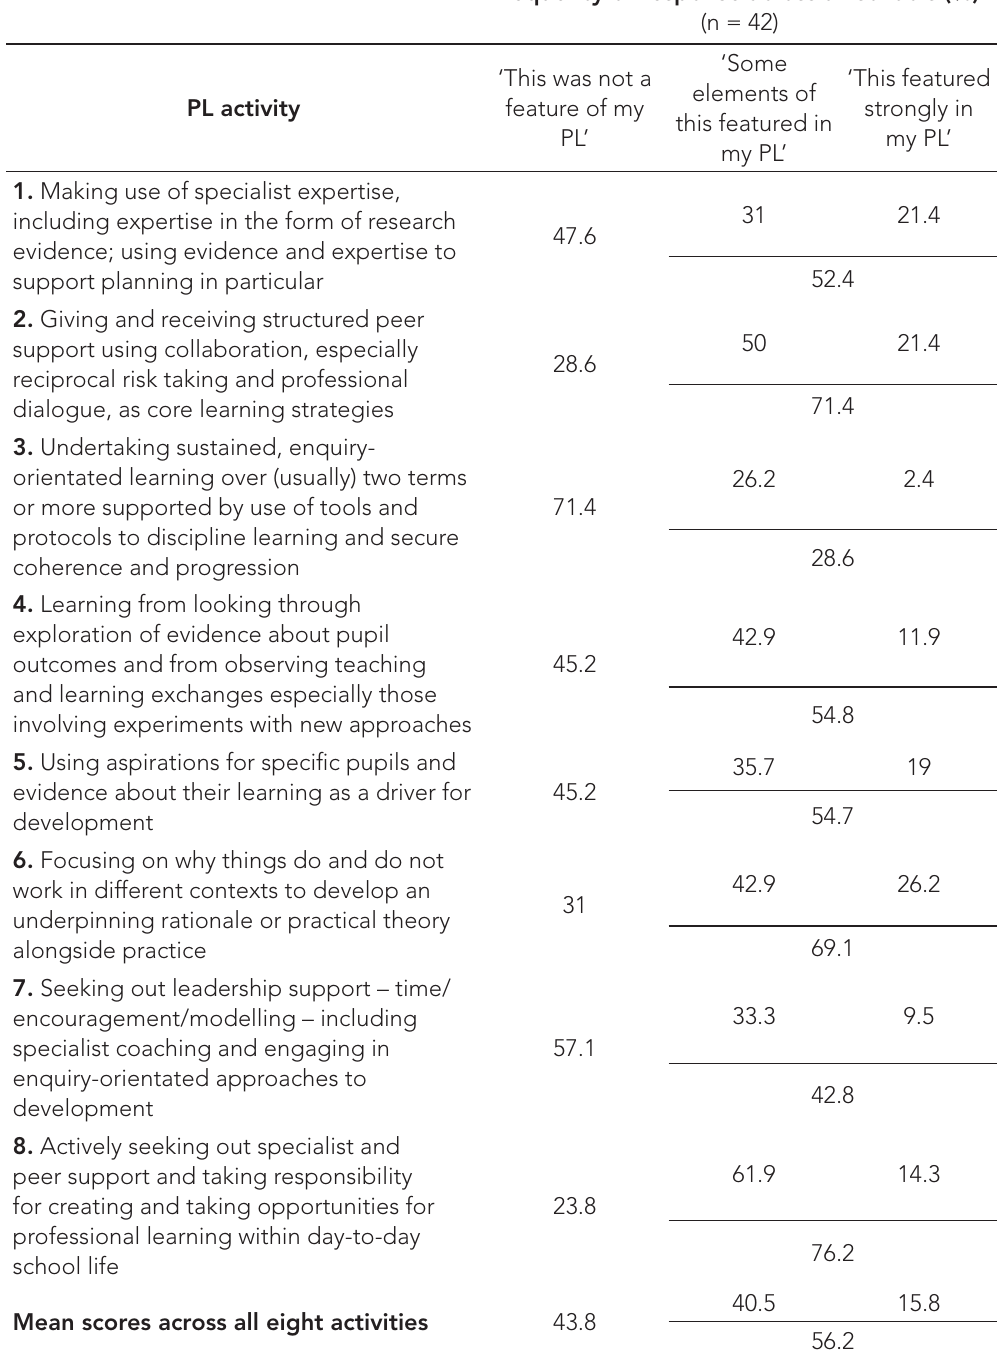
Table 2: The extent to which teachers perceived their recent PL activities to be characterized by the eight teacher activities linked to effective PL (Cordingley, 2015) PL activity